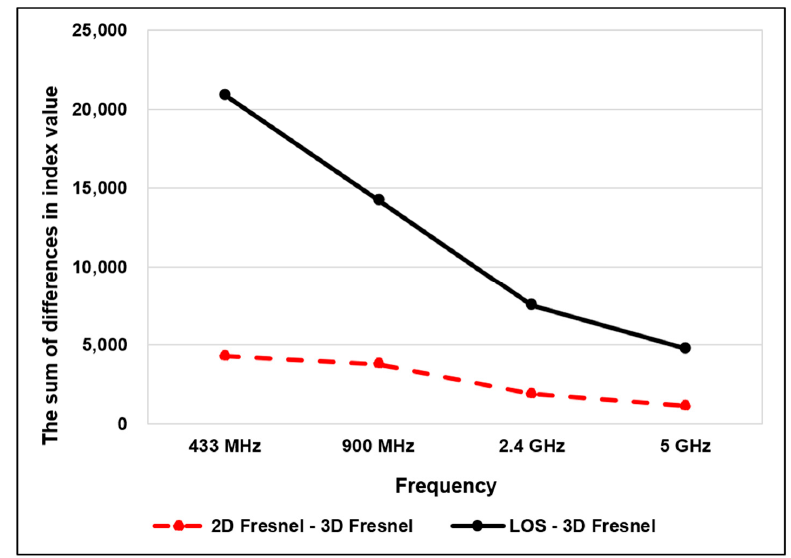
Figure 12. Differences in index value of all raster cells in the study area at different frequency thresholds.